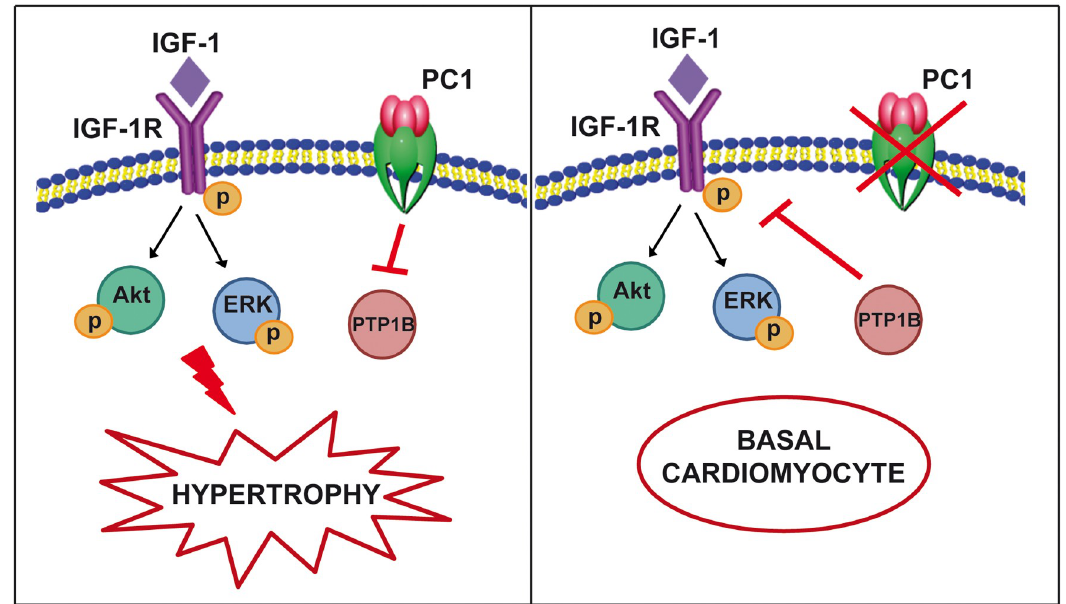
Fig 6. Graphical model of polycystin-1 and IGF-1-induced cardiac hypertrophy